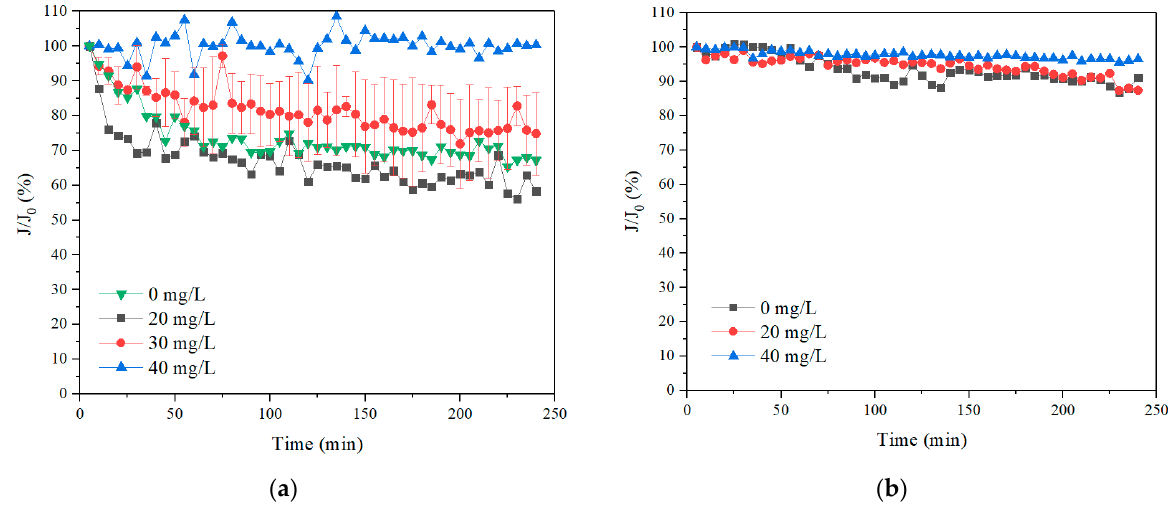
Figure 7. Permeate flux with a rotation speed of 30 r/min and different coagulant dosages, ( a ) SA, and ( b ) TA.